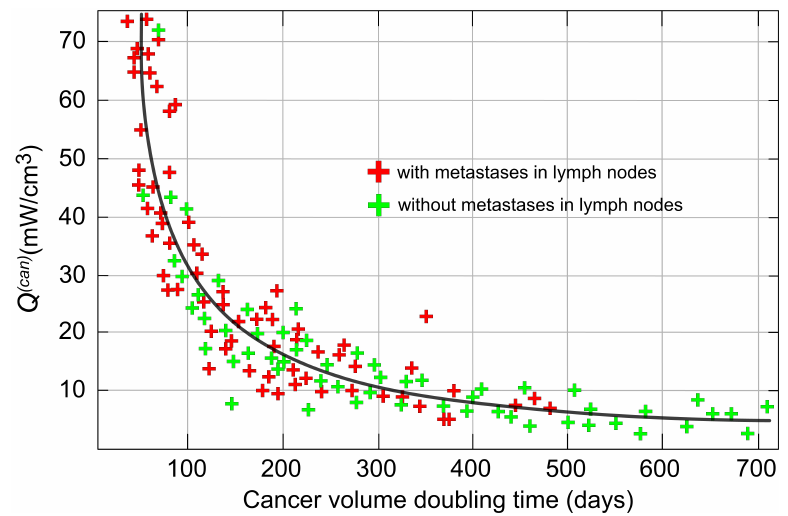
Figure 4. Dependence of tumor specific heat release Q ( can ) on doubling time for 128 breasts, where tumor diameter is 0.4 cm ≤ D ≤ 4 cm